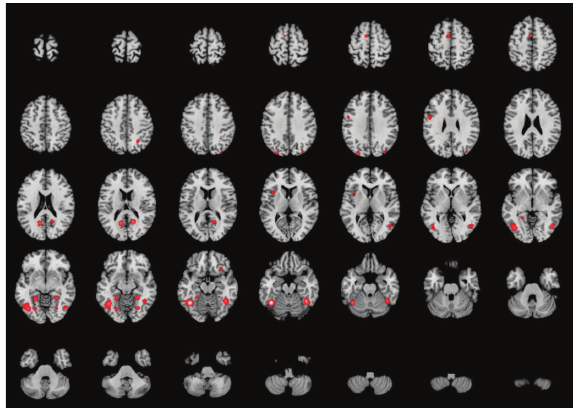
Figure 2: Visuospatial-related BA37’s network. Same conventions and setting as described previously. The highest ALE scores are located on the left and right fusiform gyri (3–5 insets in fourth row) and parahippocampal and posterior cingulate gyrus (medial posterior activation in first two columns). Smaller and less intense activations appear in the left lateral premotor area, left SMA, left insula, and left inferior frontal gyrus. The intraparietal sulci activate bilaterally.